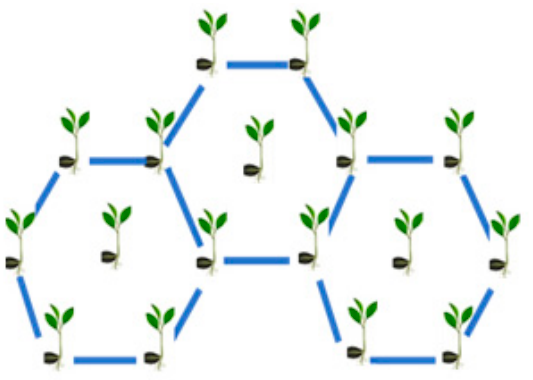
Figure 3. Hexagonal pattern of planting.